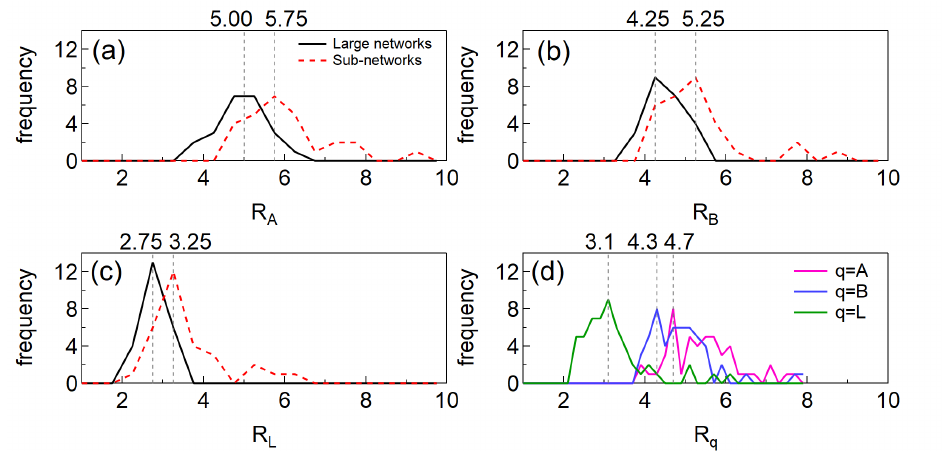
Figure 3. ( a – c ) Frequency distribution of the mean values R A , R L , R B for large networks (continuous line in black) and sub-networks (pointed-lines in red); ( d ) Frequency distribution of all the units. The peaks of each curve were included as a guide to the eye.